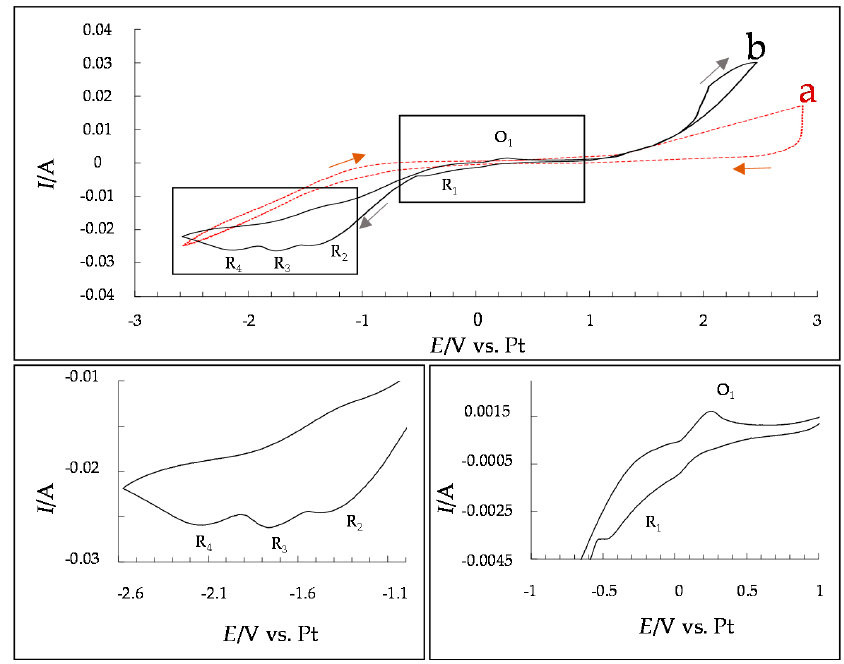
Figure 4. Cyclovoltammogram in pure [EMIM]Cl electrolyte as background (( a ), red) and [EMIM]Cl with 0.075 mol/L SnCl 2 and 0.225 mol/L CuCl 2 at a sweep rate of 0.01 V/s (( b ), black).